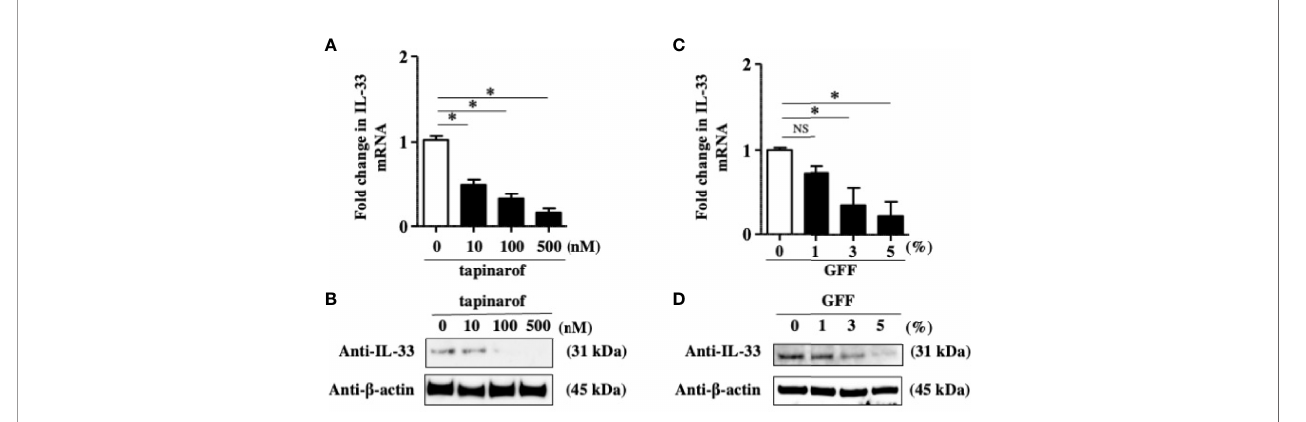
FIGURE 3 | Tapinarof and GFF treatment downregulated IL-33 in NHEKs. (A – D) NHEKs were treated with either tapinarof (500 nM) or GFF (5%) for 48 h. (A, C) IL- 33 mRNA expression was analyzed by qRT-PCR. Data are expressed as mean ± S.E.M.; n = 4 for each group. NS, not signi fi cant, *p < 0.05 (one-way ANOVA with Tukey ’ s multiple comparisons test). (B, D) IL-33 protein expression was analyzed by western blotting with an anti-IL-33 antibody. The data are representative of experiments repeated three times with similar results.